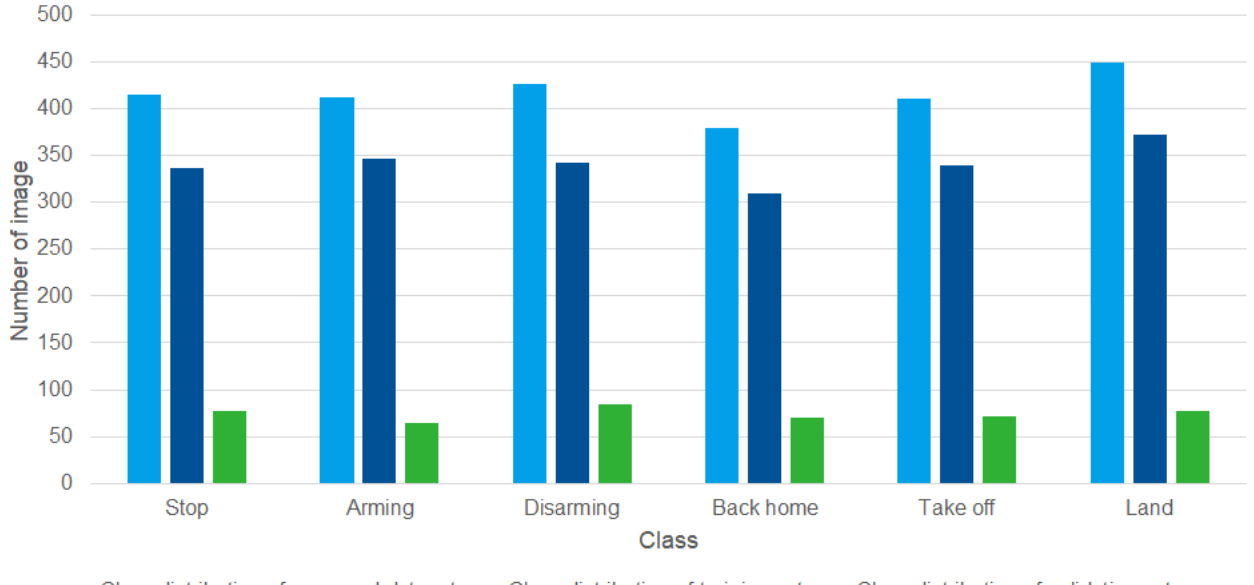
Figure 7. The class distribution of dataset. The X -axis represents class, and the Y -axis represents the number of images for each class.